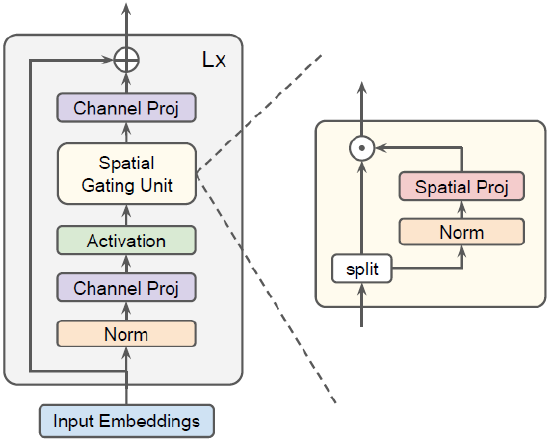
Figure 5. gMLP architecture with Spatial Gating Unit (SGU) [33].